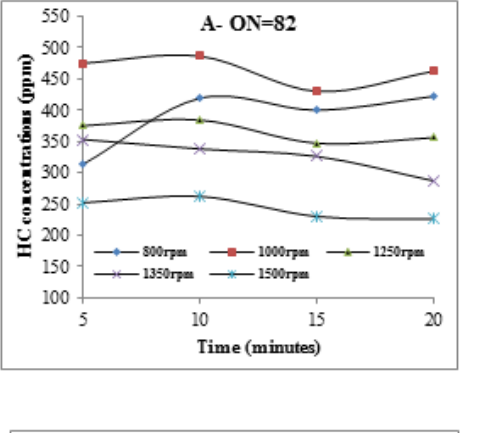
Fig. 7 represents the emitted NOx for the studied cases. NOx concentrations are very low and reach zero sometimes at idle speed except for 1350 and 1500 rpm for regular gasoline and M20.